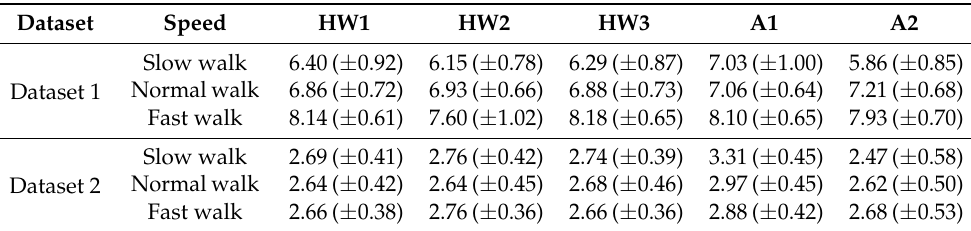
Table 3. Average frequency (in terms of the number of maximum peaks per sequence) of the quasi- periodic signals obtained with the five ratio-based body